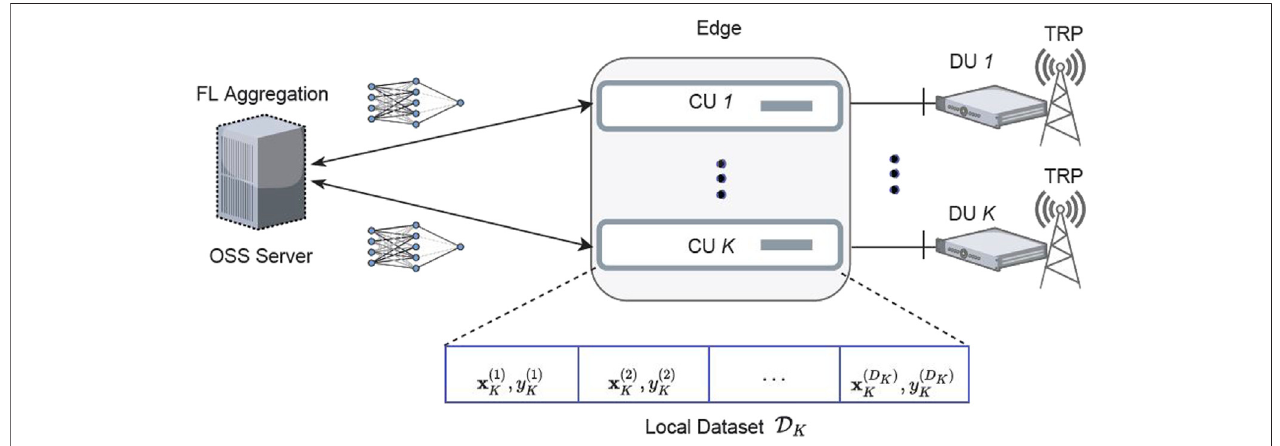
FIGURE 1 | Network architecture.